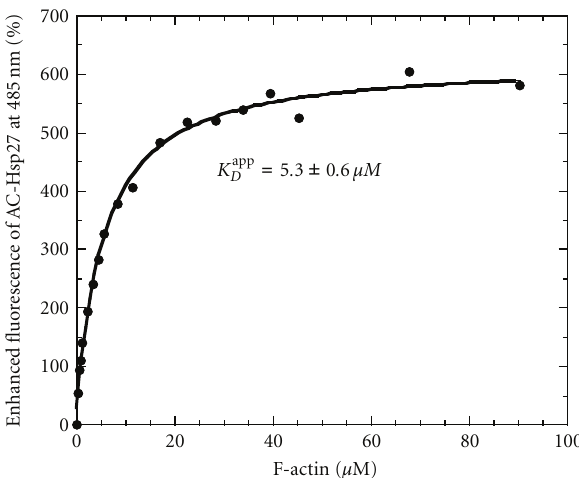
Figure 4: Fluorescence of AC-Hsp27 titrated with F-actin. Percent fluorescence enhancement at 485 nm as a function of actin con- centration in F-bu ff er at 37 ◦ C. AC-Hsp27 = 1 μ M. The best fit of the data yielded an apparent dissociation constant K app D = 5 . 3 ± 0 . 6 μ M with the actin/Hsp27 molar stoichiometry fixed at 1.0. The error in K app D is calculated from the root mean square deviation of data points from the fit.